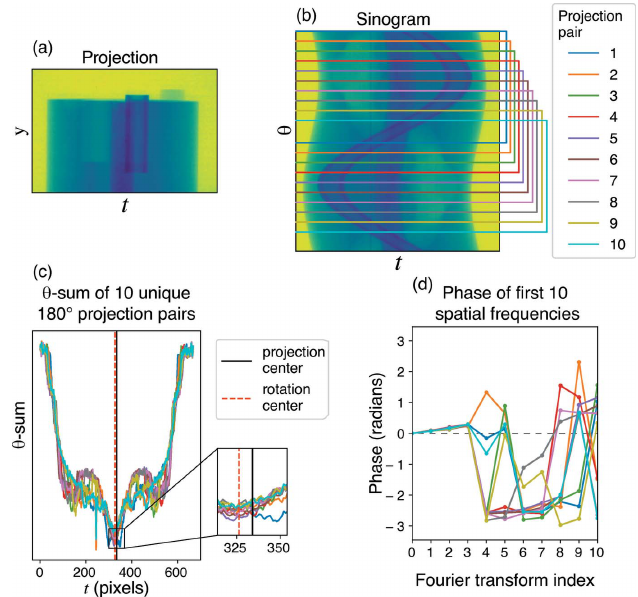
Figure 3 Demonstration of the projection pair approach. Using data set tomo_00030 from TomoBank (De Carlo et al. , 2018) ( a ), ten sets of (cid:2) - sums were obtained from projection pairs that were each separated by 180 (cid:2) in the sinogram ( b ). The corresponding (cid:2) -sums for each projection pair are shown in ( c ), with both the projection center as recorded in the data set and the recovered rotation center shown. Because an offset from centrosymmetry leads to a phase ramp in Fourier space, Fourier transforms of each of these (cid:2) -sums shown in ( d ) all show the same phase ramp at the first spatial frequency index (that is, the lowest spatial frequency in the Fourier transform), with higher spatial frequencies then reflecting variations due to what exact features are present in the projection pair. The correct rotation center is recovered from the phase of the first spatial frequency